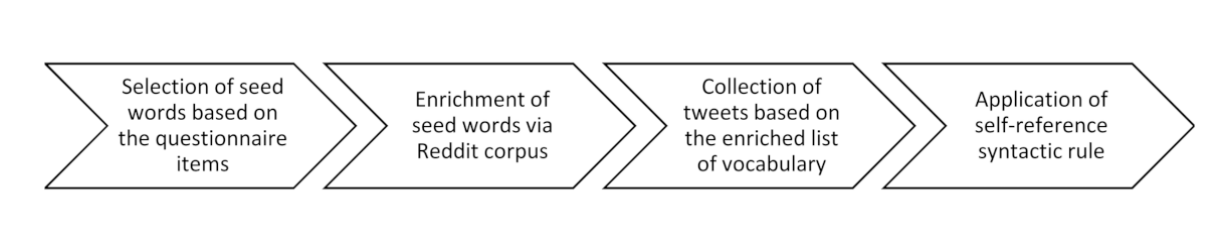
Figure 1. Flowchart summarizing the Twitter data collection